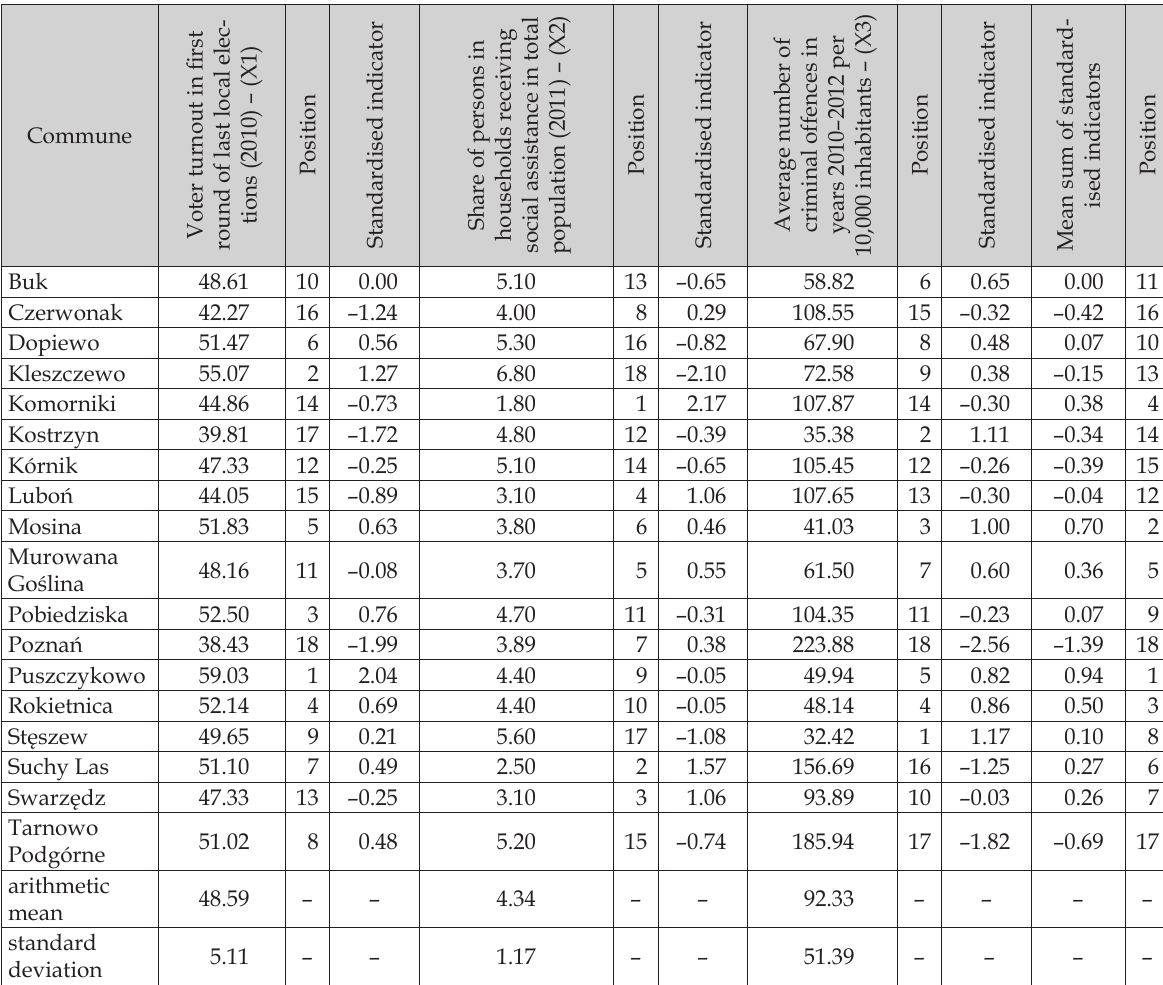
Table 1. Differences among the communes of the Poznań agglomeration in terms of social indicators.